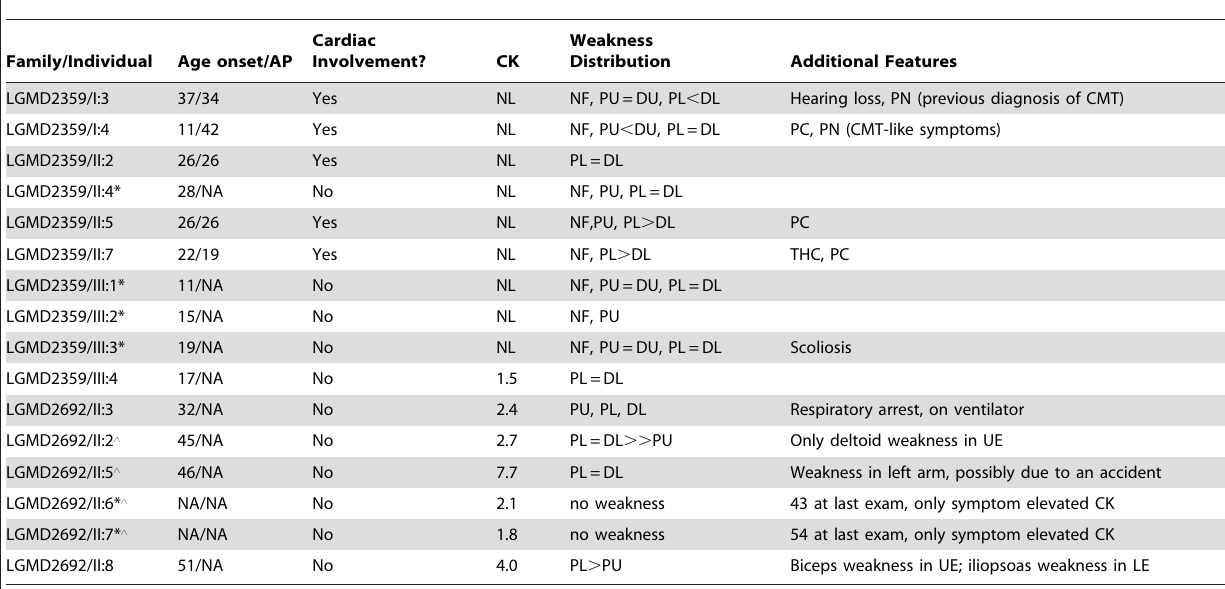
Table 1. Clinical description of individuals with skeletal muscle weakness and/or elevated creatine kinase in LGMD2359 and